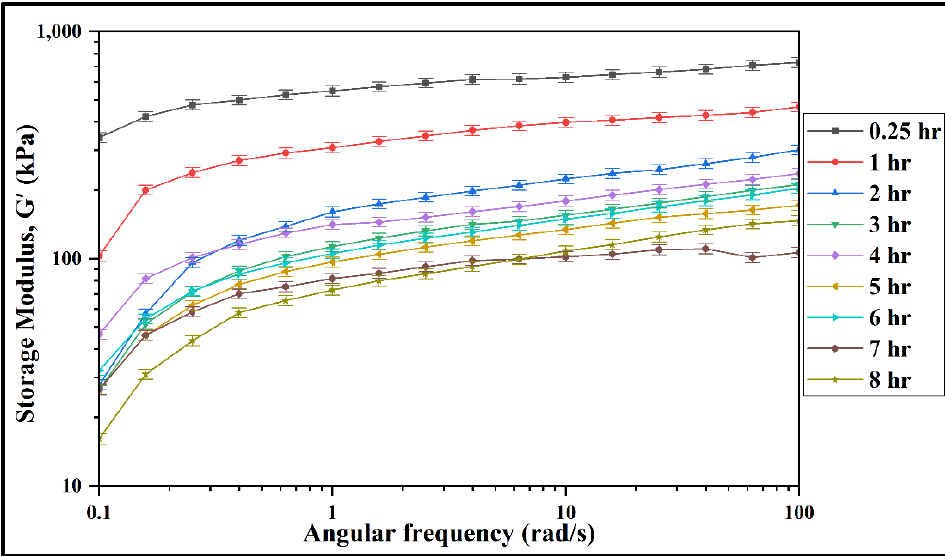
Figure 11. Storage modulus vs. angular frequency graphs at 9 different levels of waiting time.